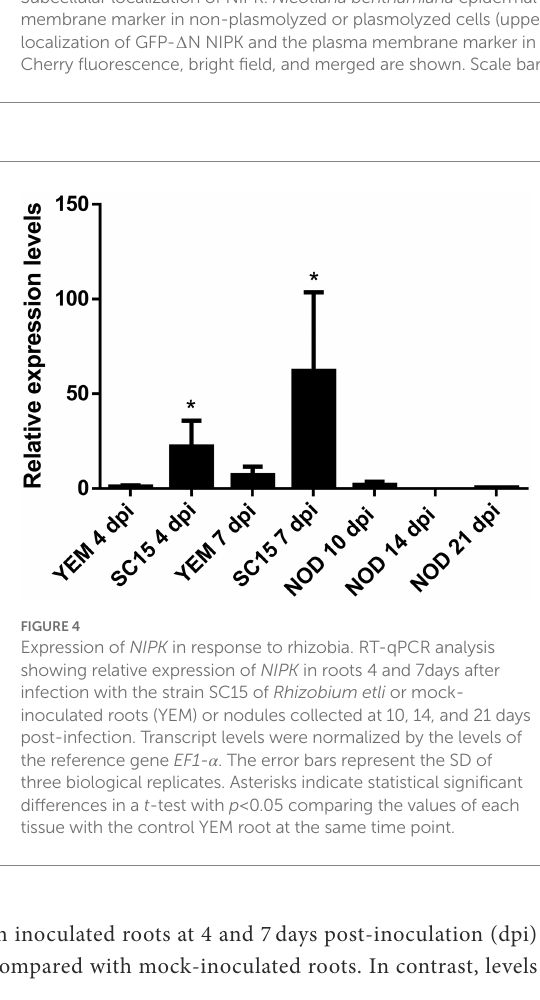
NIPK were lower in 10 dpi nodules than in inoculated roots, and expressed at very low levels in nodules of 14 and 21 dpi (Figure 4). An inspection of expression data at the P. vulgaris